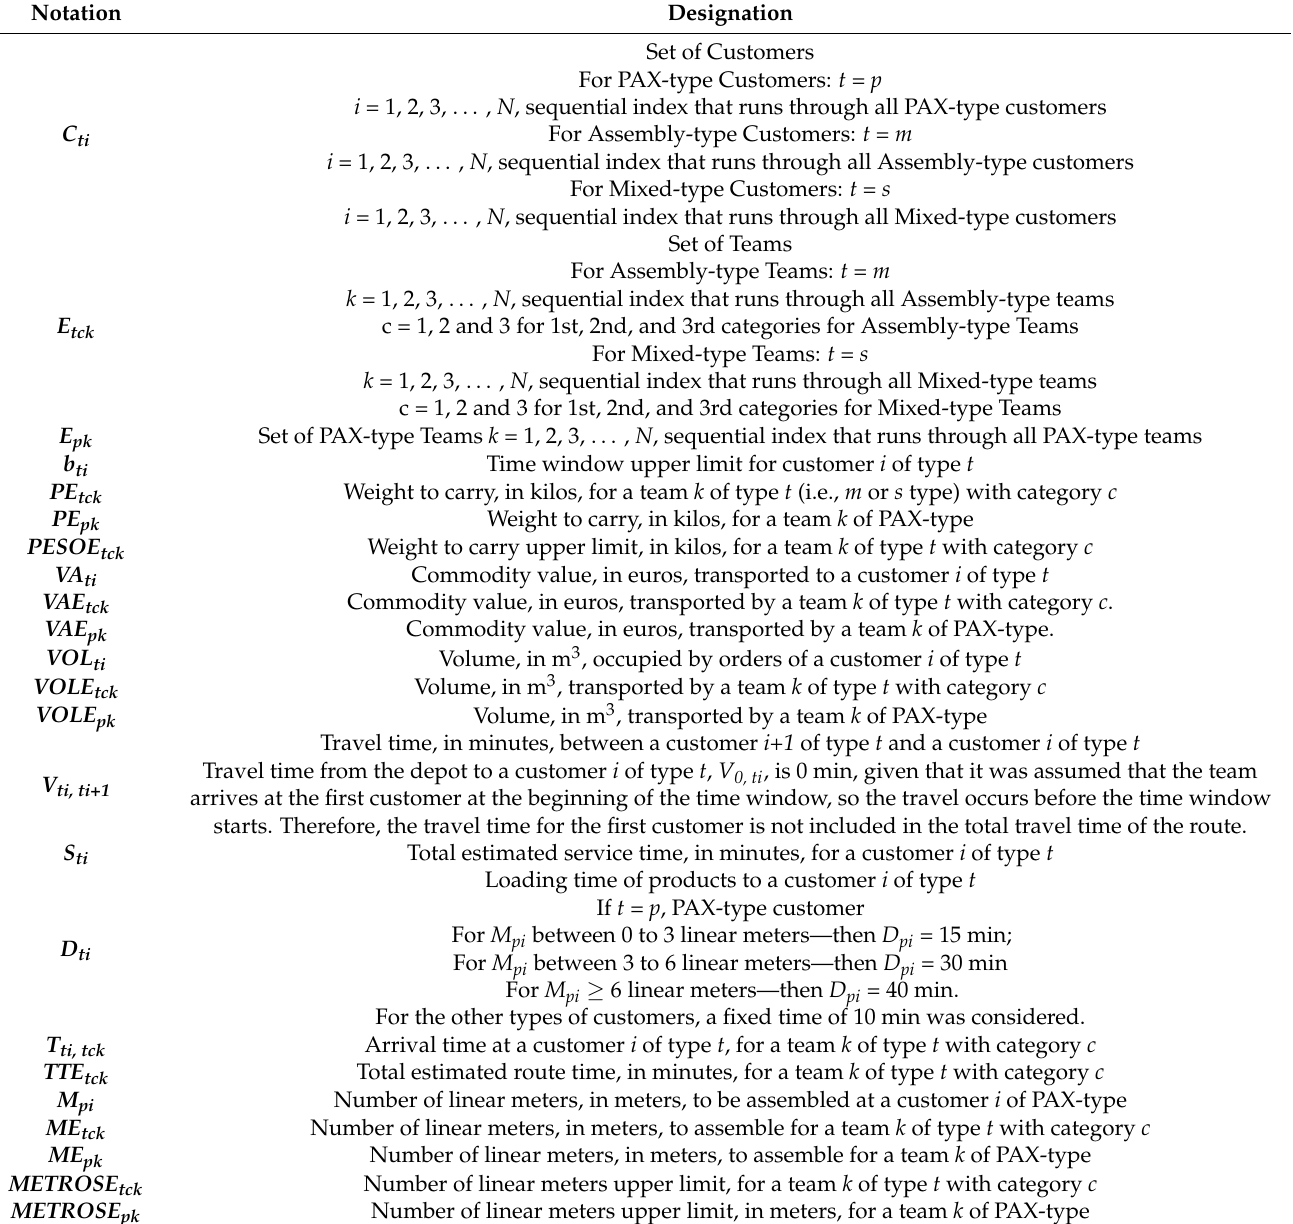
Table 5. Notation used for the purposed